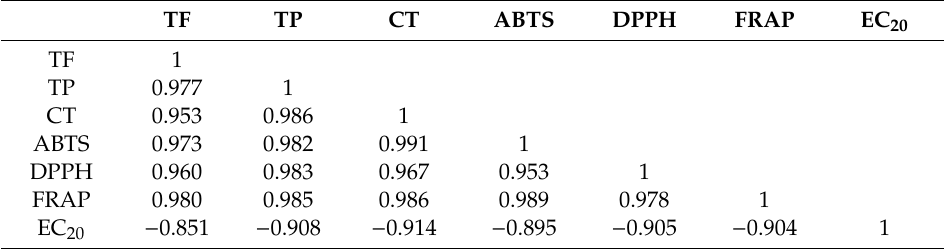
Figure 1. Representation of the relations between the total polyphenols content (GAE) and the parameters ABTS ( a ), DPPH ( b ), FRAP ( c ) and EC 20 ( d ). ABTS, 2,2′-azino-bis-3-ethylbenzothiazoline- 6-sulfonic acid; FRAP, ferric reducing antioxidant power; DPPH, 2,2 diphenyl-1-picrylhydrazyl; EC 20 , Efficient Concentration. Table5. Correlationmatrixbetweentheparametersdescribingthepolyphenoliccontent(totalflavonoids (TF), total polyphenols (TP) and condensed tannins (CT)), and the results of the antioxidant